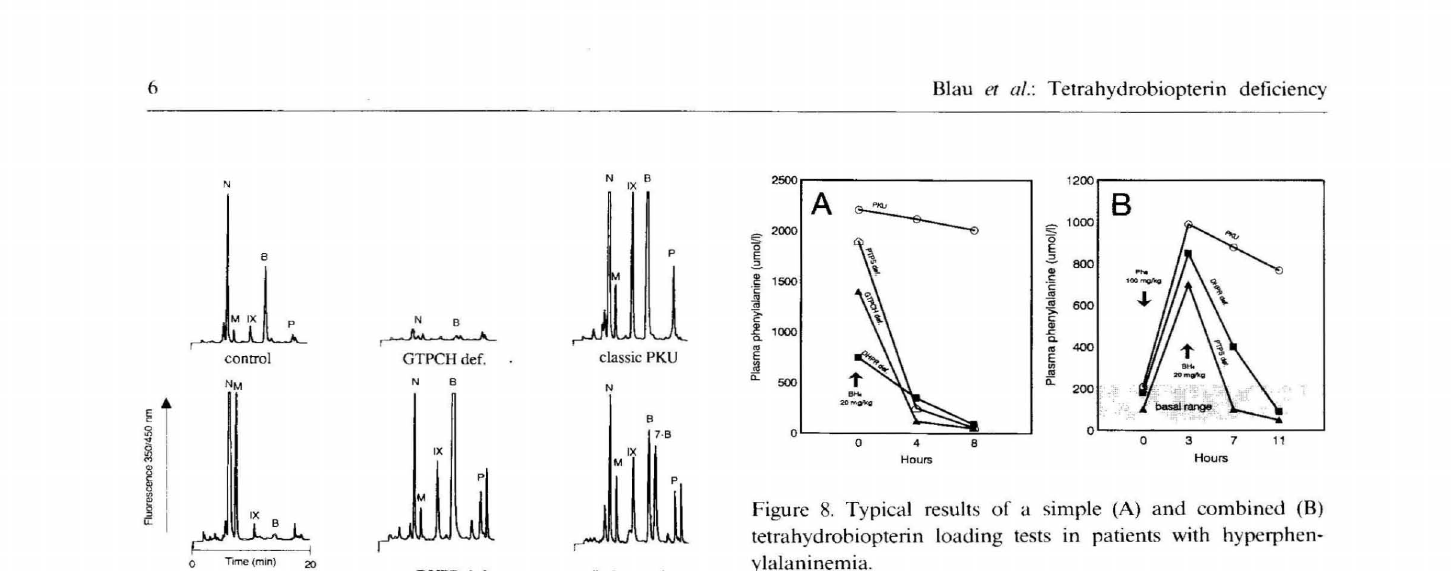
Figure 8. Typical results of a simple (A) and combined (B) tetrahydrobiopterin loading tests in patients with hyperphen